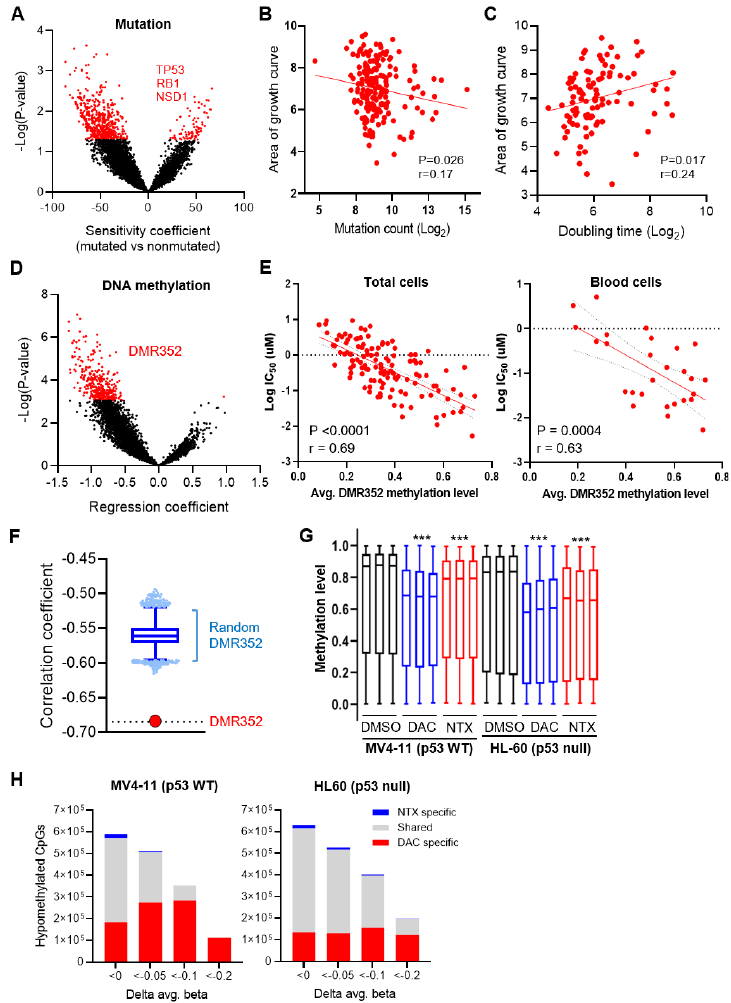
Figure 6. Integrative analyses using 199 CCLs identified mutational and epigenomic events that are associated with sensitivity to NTX-301. ( A ), A volcano plot showing mutational events that are associated with sensitivity to NTX-301. On the X-axis, negative coefficient values indicate the skewing of each event toward the responders relative to the nonresponders. The red dots highlight significant events that were identified by the cutoff criteria of p < 0.05. ( B , C ), Scatter plots showing the log 2 -transformed mutation count ( B ) and doubling time ( C ) of CCLs plotted against the corresponding AUC values after NTX-301 treatment. ( D ), A volcano plot showing DNA methylation events that are associated with sensitivity to NTX-301. On the X-axis, negative coefficient values indicate the skewing of each event toward the responders relative to the nonresponders. The red dots highlight significant events (DMR352) that were identified by the cutoff criteria of a false discovery rate (FDR) < 0.05. ( E ), Scatter plots showing correlations between the average methylation level of DMR352 and the log-transformed IC 50 value in all of the CCLs (left) and blood CCLs (right). p values and correlation coefficients (r) are shown. ( F ), Plot comparing correlation coefficients between the defined DMR352 and a random DMR352 (100,000 iterations of 352 randomly selected regions). ( G ), Box plots showing the distribution of levels of methylation ( β -values) in 862,927 CpGs in triplicate samples of MV4-11 and HL-60 cells treated with NTX-301 or DAC (60 nM for MV4-11 and 30 nM for HL-60). ***, p < 0.0001. ( H ), Bar plots showing the number of demethylated CpGs among 862,927 CpGs in MV4-11 (left) and HL-60 (right) cells after treatment with NTX-301 or DAC. Demethylation was defined by the criteria of p < 0.05 and ∆ β < 0, < − 0.05, < − 0.1, and < − 0.2. ‘Shared’ indicates CpGs that were demethylated by both NTX-301 and